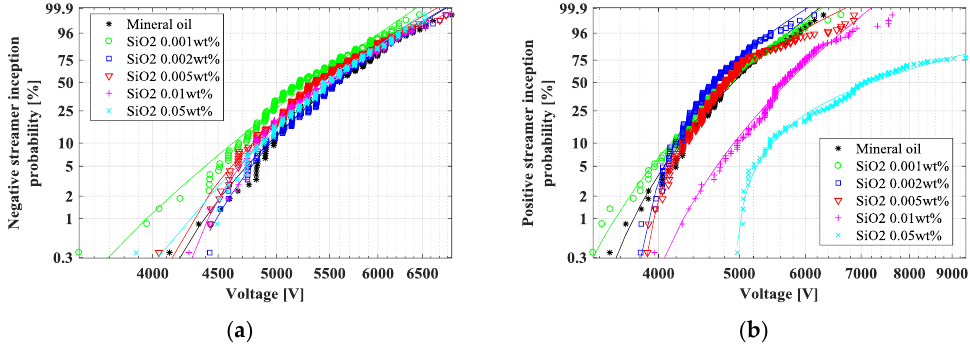
Figure 3. Streamer inception cumulative probability of SiO 2 nanofluids at different mass concentrations under ( a ) negative and ( b ) positive polarity. The reference data of mineral oil is added for sake of comparison. The corresponding fitting Weibull functions are shown as solid lines.